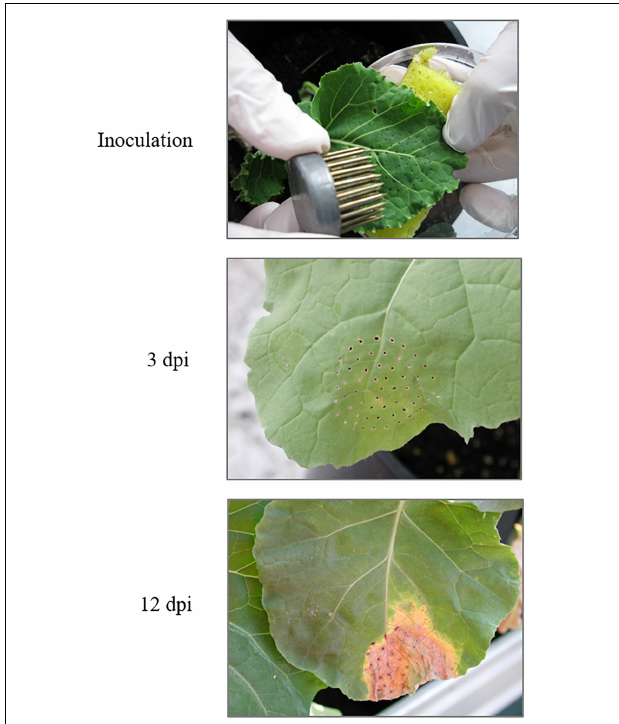
FIGURE 1 | Inoculation and symptoms in Brassica oleracea leaves caused by Xanthomonas campestris pv. campestris 3 dpi and 12 dpi. dpi: days post-infection (source: adapted from Tortosa et al., 2019).